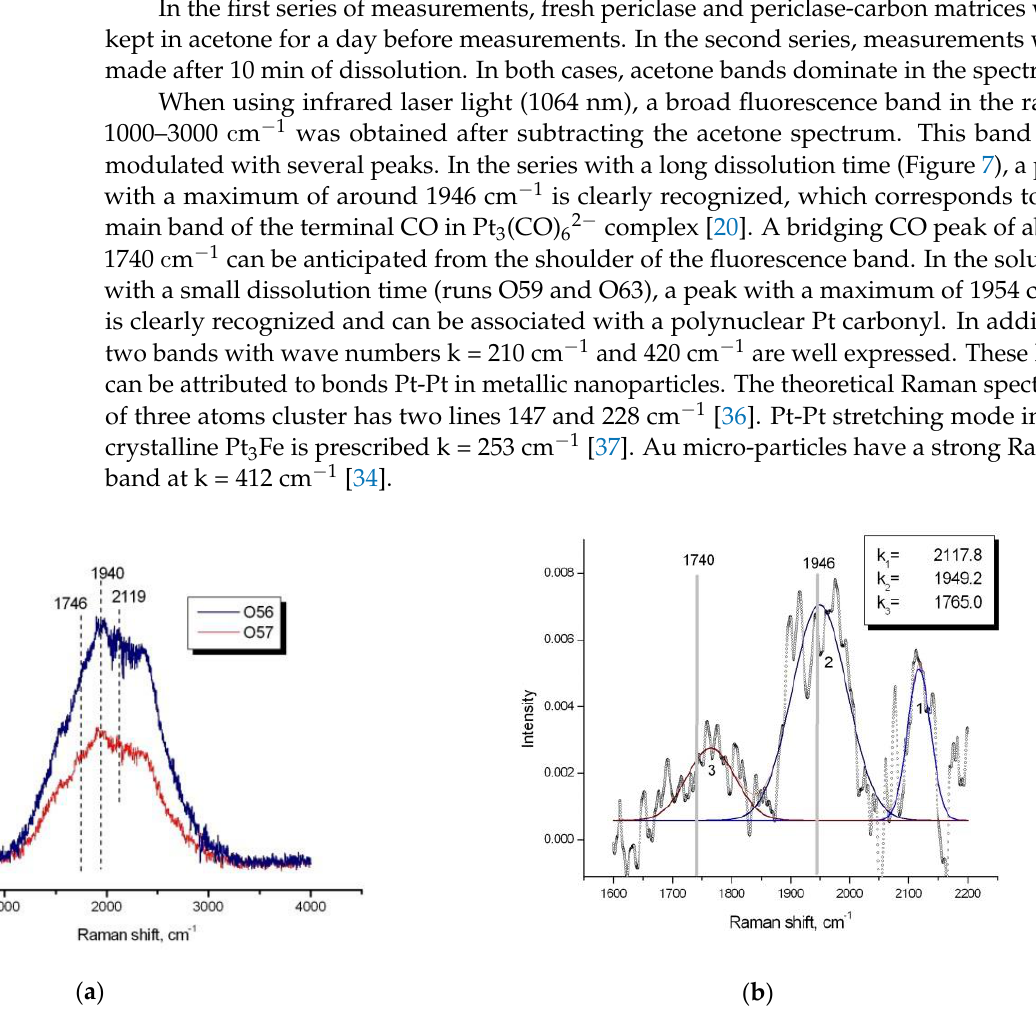
Figure 7. Spectra of the solution in acetone of quenched phases in periclase-carbon matrix from the runs O56 and O57 measured with red laser (spectrum of pure acetone is subtracted), dissolution time of a day; ( a ) fluorescence band with peaks, peaks of Pt carbonyl are labeled with vertical dashed lines; ( b ) peaks assignment for the O56 spectrum (broad fluorescence band is subtracted).